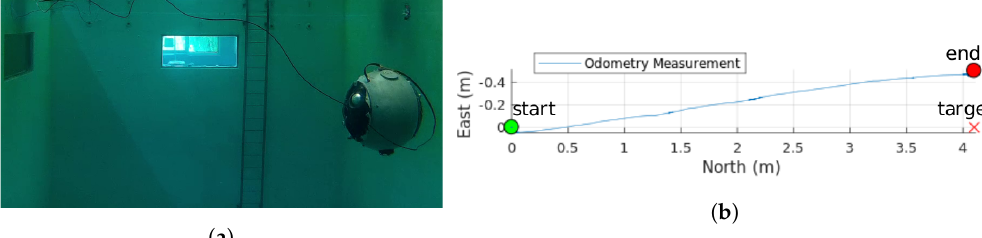
Figure 11. Drift in East ( y ) direction caused by the tether ( a ) UX-1 with the tether; ( b ) Odometry